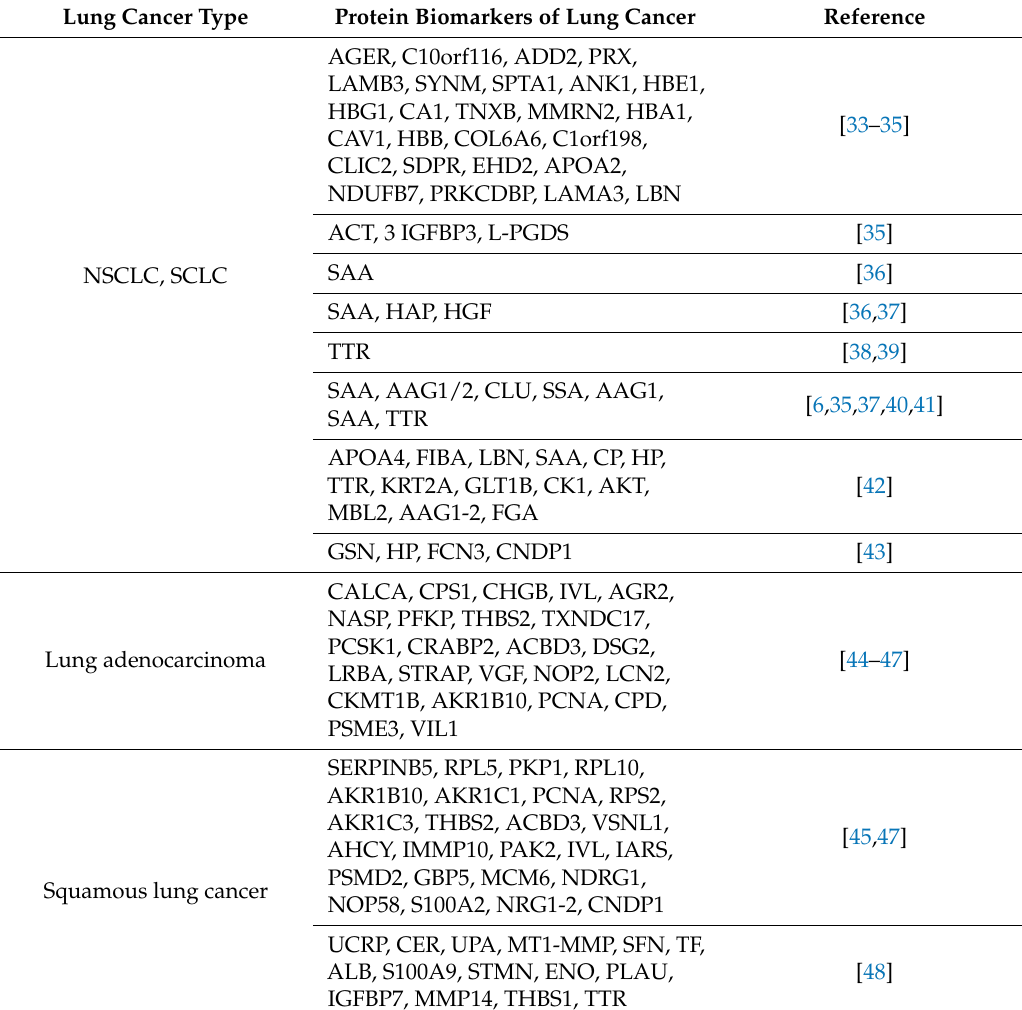
Table 1. Protein biomarkers of lung cancer defined using proteomic